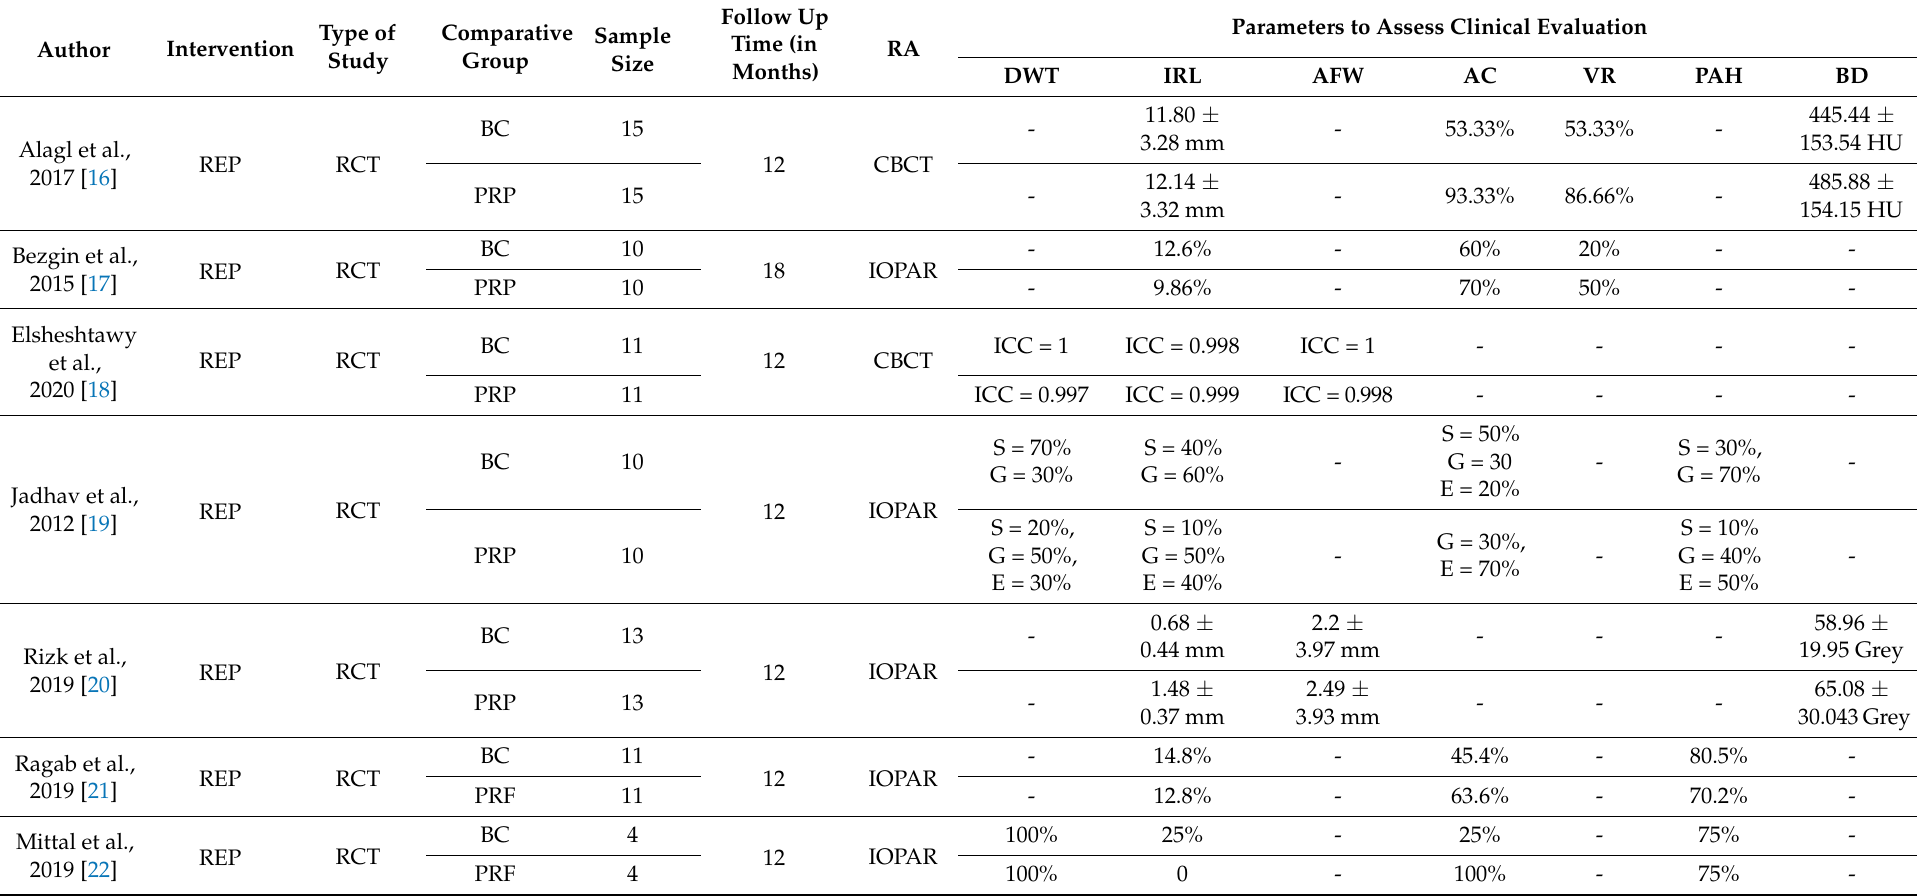
Table 4. Data extraction from included studies for qualitative analysis – clinical evaluation